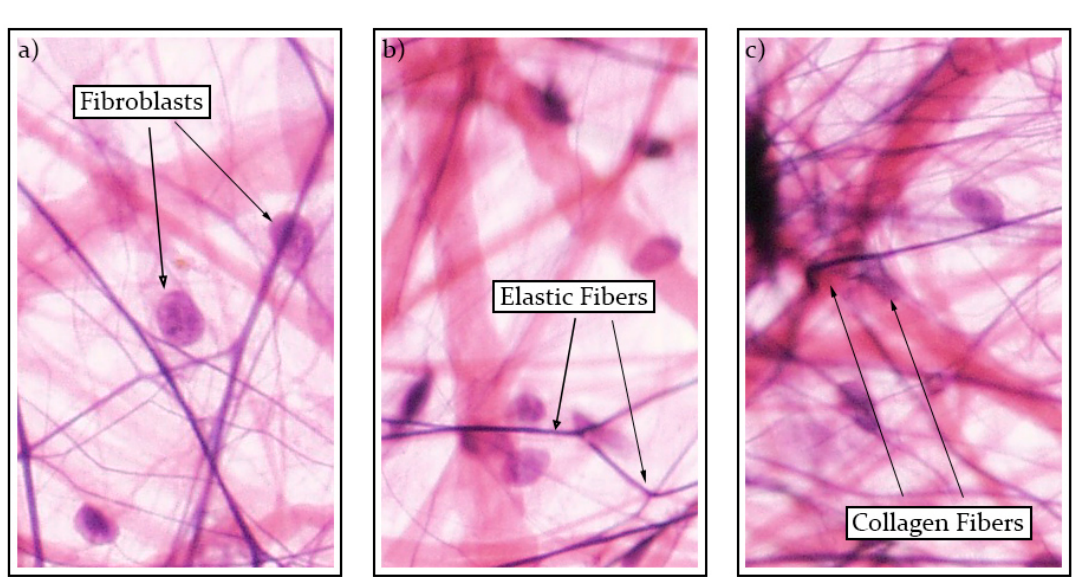
Figure 1. Visualization of individual findings found in fibrotic liver tissue samples. ( a ) Fibroblasts as principal cells accompanying almost all connective tissues. ( b ) Thin elastic fibers produced by the elastin protein. ( c ) Advanced accumulation of broad collagen fibers, which can lead to the end-stage of hepatic cirrhosis.